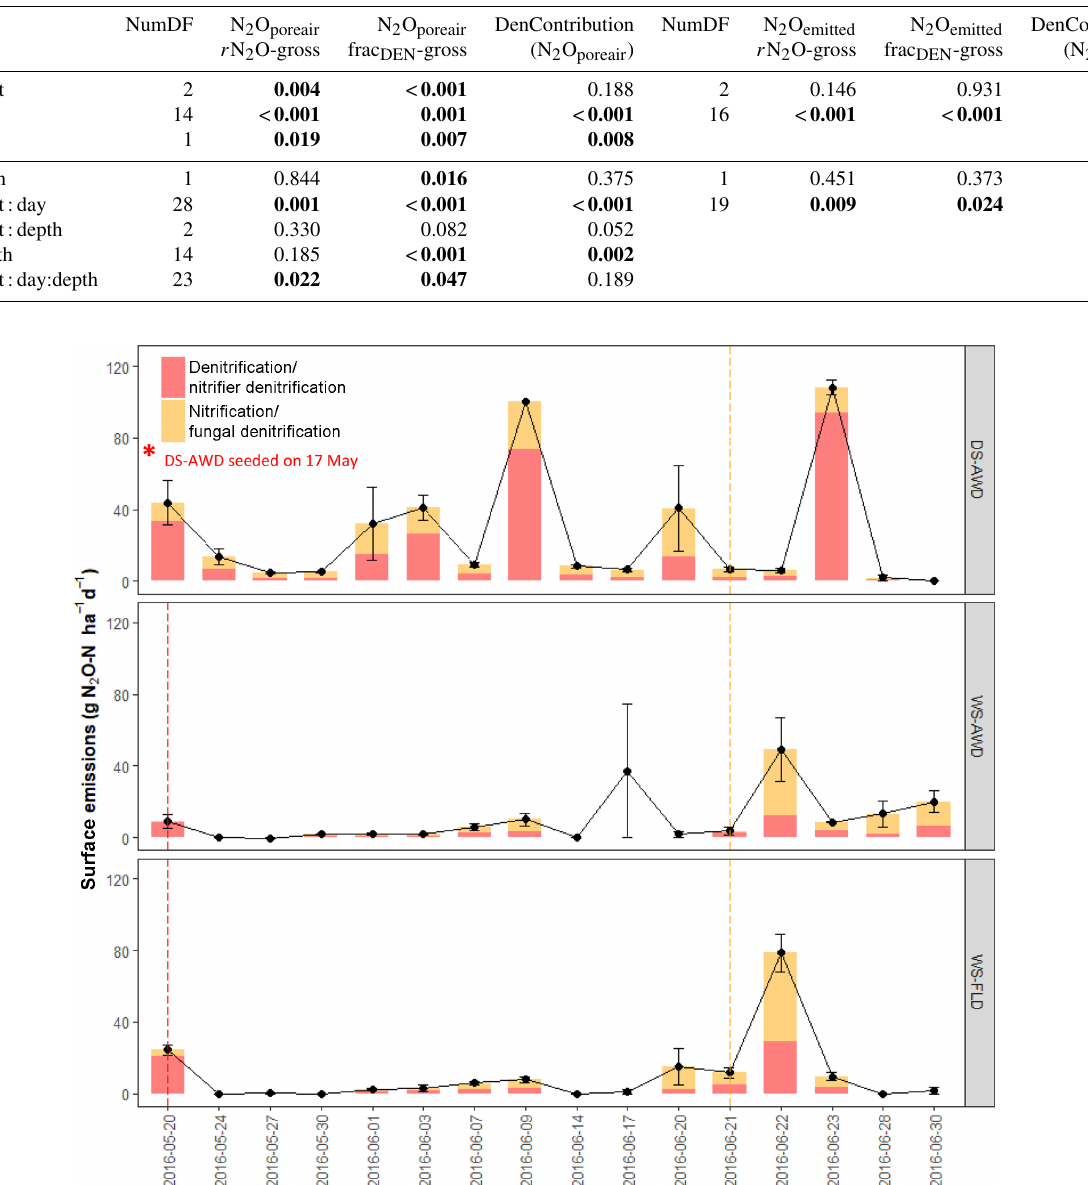
Table 5. P -value ANCOVA results of modeled residual N 2 O not reduced (gross r N 2 O), fraction of total N 2 + N 2 O production coming from denitrification (gross frac DEN ), and the fraction of N 2 O attributed to denitrification (DenContribution) derived from N 2 O emitted and N 2 O poreair . The Y position was used a covariate and represents the longitudinal position of each replicate within the field. Numbers in bold indicate significance at p< 0 . 05.